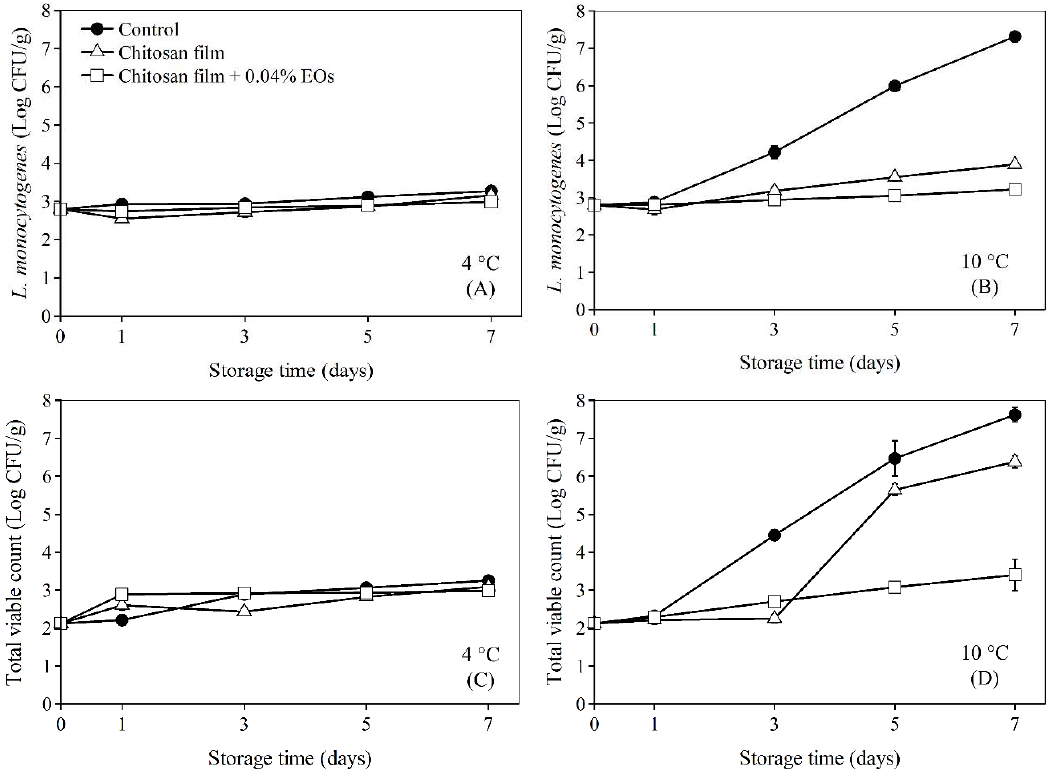
Figure 3. Number of L. monocytogenes at 4 °C ( A ), 10 °C ( B ) and total viable counts at 4 °C ( C ), 10 °C ( D ) on bologna stored for seven days. Error bar represents standard deviation over three repeats.